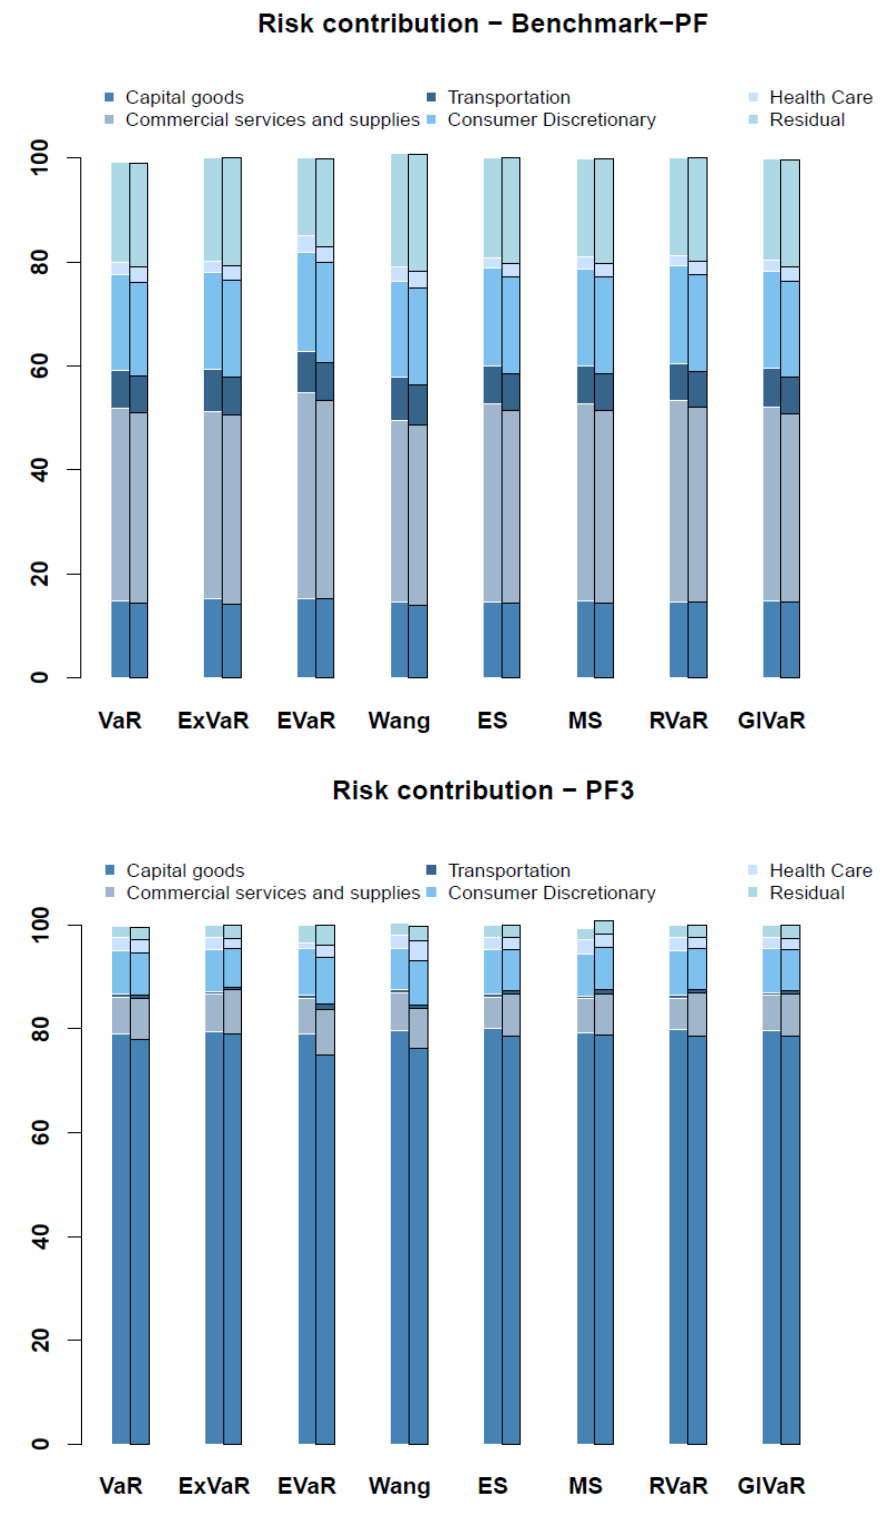
Figure 2. Sensitivity of risk